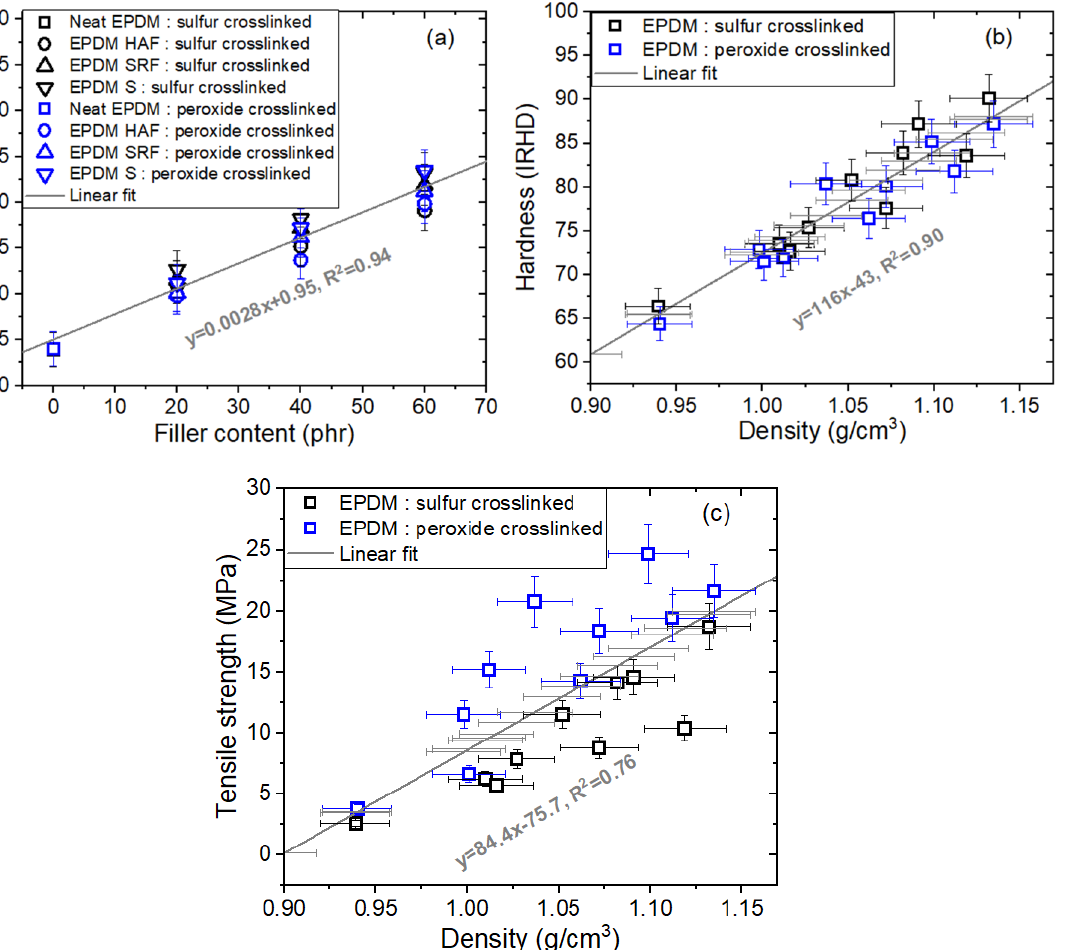
Figure 7. Linear correlations between ( a ) density and filler content, ( b ) hardness and density, and ( c ) tensile strength and density for EPDM composites blended with CB and silica. The data for neat EPDM are included in the linear fit to show the consistency with the fits for the filled blended EPDM composites. The black lines were fitted with the positive linear relationship. R 2 is the squared correlation coefficient indicating the fit between the data and the linear equation.